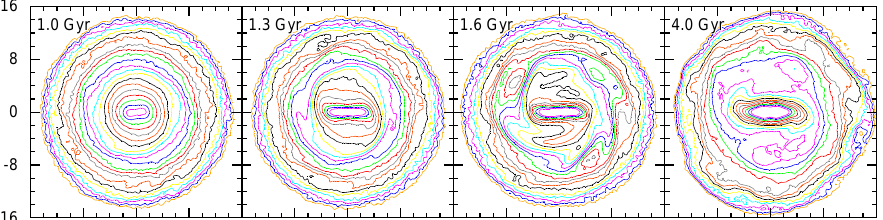
Fig. 2. Bar patterns oriented along the x -axis during different stages of bar evolution. The curves are the density contours evenly spaced in log scale (10 levels for every factor of 10). Each frame size is 32 × 32 kpc 2